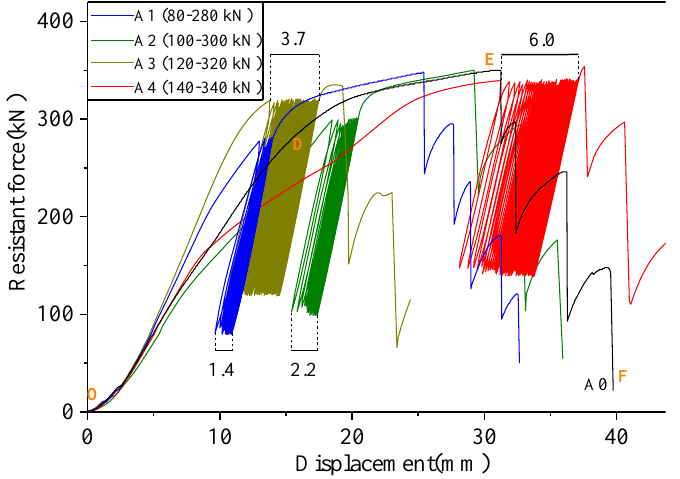
Figure 13. Tensile resistance–displacement curve of equal-lower-limit-and-equiamplitude cyclic loading.